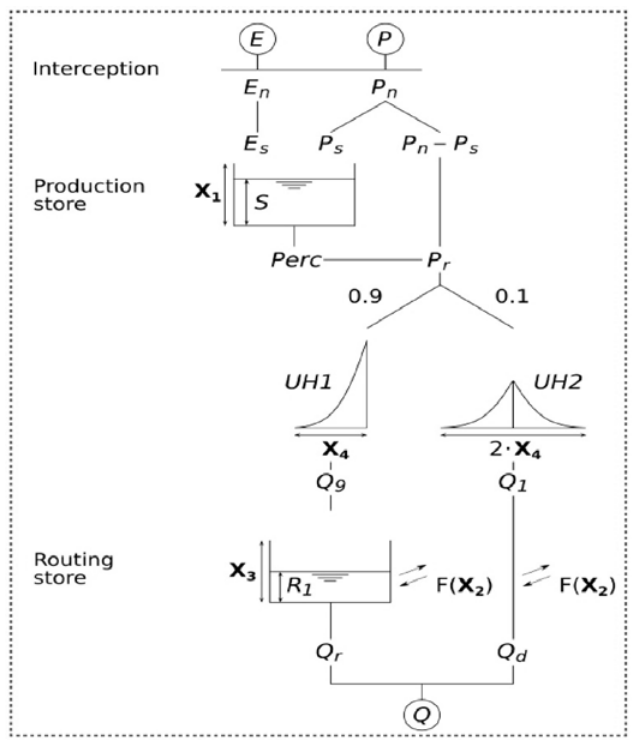
Figure 3. GR4J rainfall–runoff model diagram (modified from [73]). The GR4J model employs four parameters—X 1 : maximum storage capacity (mm); X 2 : groundwater exchange coefficient (mm); X 3 : maximum channel transit capacity (mm); and X 4 : base time of unit hydrograph (days) [22] (Figure 3).